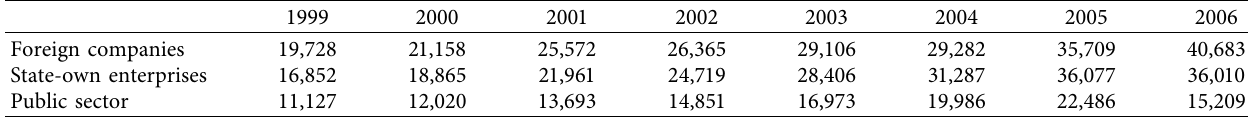
Table 1: Relevant information on the average wages in different kinds of enterprises.